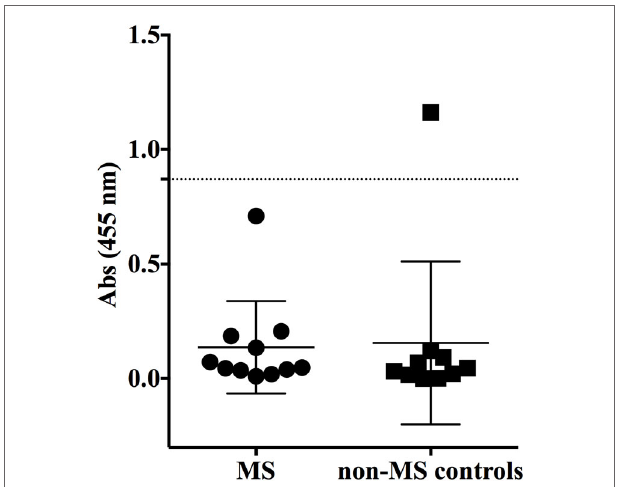
FigUre 3 | Ms and control-derived rigg binding to protocadherin gamma (PcDhgc3) by solid phase elisa . MS-derived rIgG ( n = 11) and control rIgG ( n = 10) derived from a germinoma and muscle tissue were tested by solid phase ELISA for binding to protocadherin. The specific samples included in the assay are shown in the Supplementary Material. Each dot or square represents the binding of a single rIgG. The dashed line indicates the mean + 2 SD of the control-derived cohort (0.87). Values above this line were determined to be positive (95% CI). The mean and SD are shown for each data set. Statistical differences are indicated when significant. Data associated with each rIgG for the MS and control groups are shown in the Supplementary